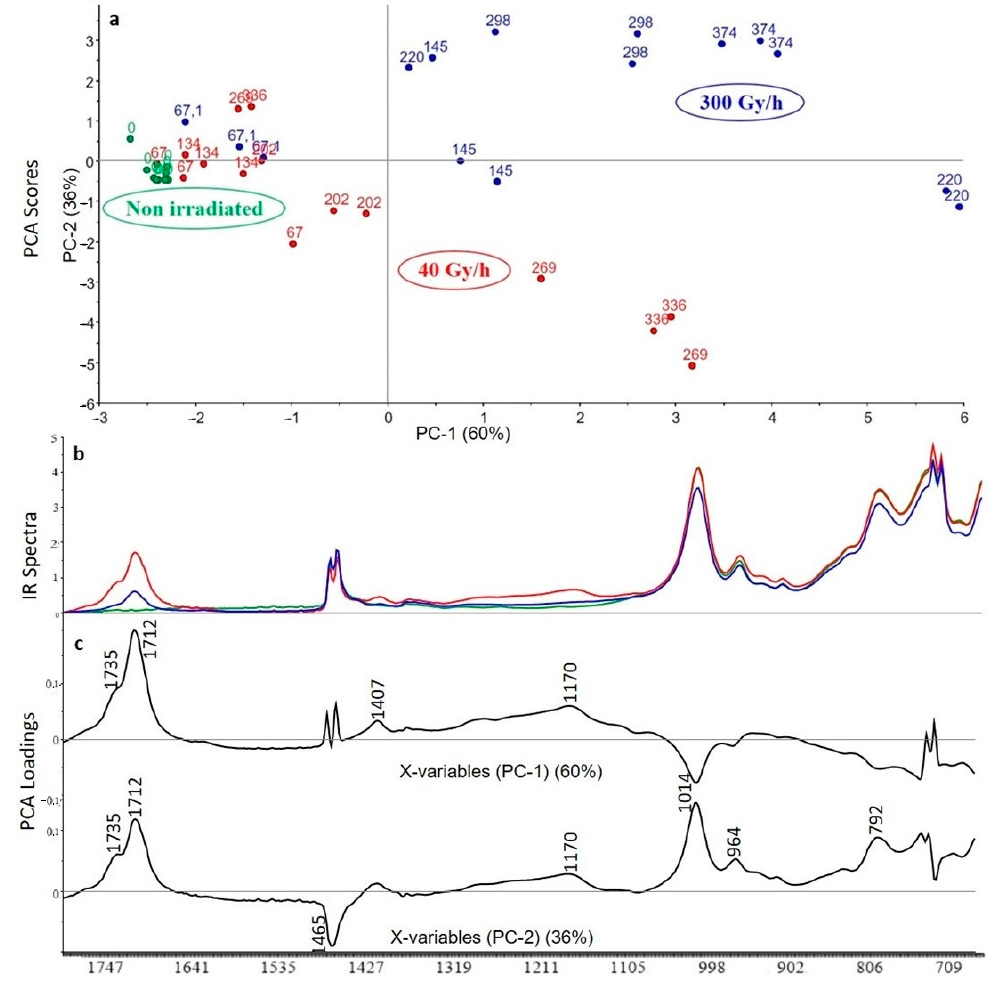
Figure 9. PCA scores ( a ), FTIR spectra for highest dose ( b) and PCA loadings ( c ) of the first and second principal components (PC1 and PC2) for the analysis of XLPE with ATH (green: unaged samples, red: samples irradiated at 40 Gy/h, blue: samples irradiated at 300 Gy/h).